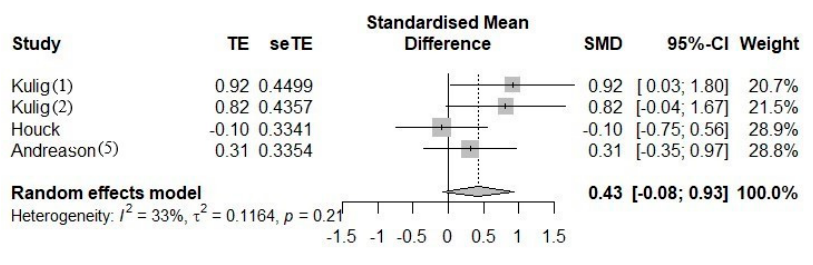
Figure 4. The forest plot between mixing foot orthoses with exercises and foot orthoses in pain.